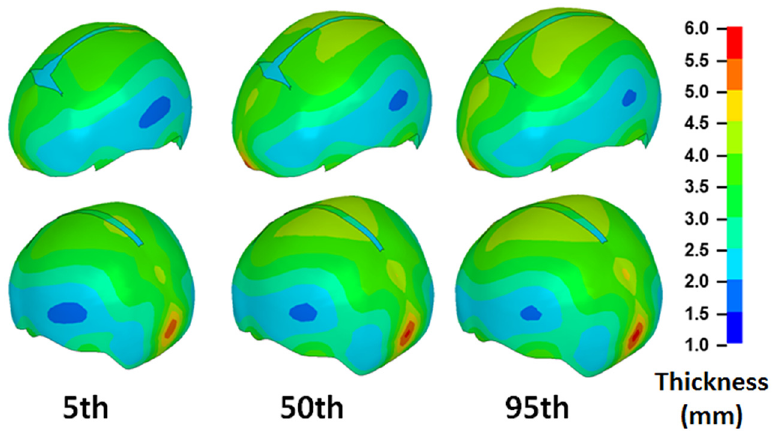
Fig 9. Skull thickness distribution variation among 1.5 YO children with a range of head circumference. The models shown here were generated by morphing a template mesh into the model- predicted skull geometry using a Radial Basis Function. The color contours were generated based on the skull thickness values associated with each node on the morphed mesh. The quantitative skull thickness data corresponding to each landmark location can be found in Table D in the S1